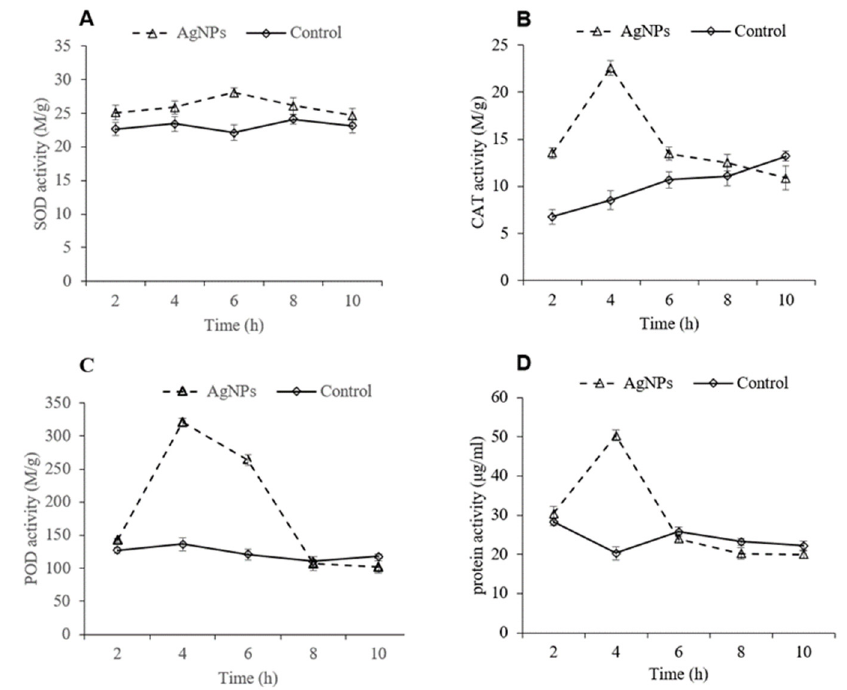
Figure 5. Activities of superoxide dismutase (SOD) ( A ), catalase (CAT) ( B ), and peroxidase (POD) ( C ) and protein concentration ( D ) of P. litchi treated with Ag-NPs.